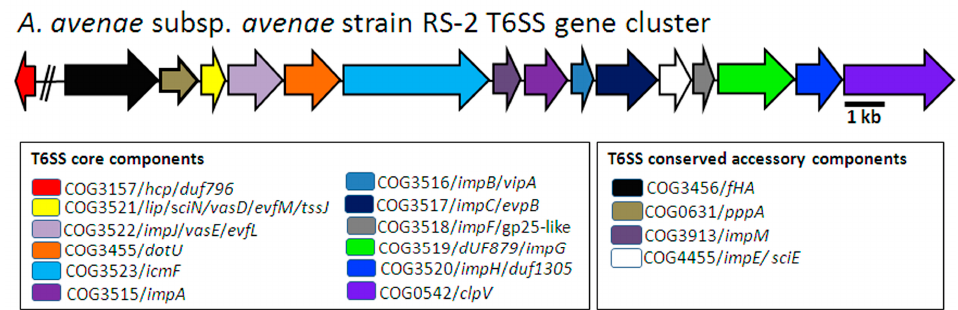
Figure 1. Schematic diagram of the genetic organization of Acidovoraxavenae subsp. avenae strain RS-2 T6SS gene cluster. Genes are indicated by arrows and the direction of the arrows represent the direction of transcription of the genes in genome. “//” indicates the presence of other genes but not belongs to T6SS. The database of Clusters of Orthologous Groups of proteins (COGs) was achieved from the National Center of Biotechnology Information (ftp://ftp.ncbi.nih.gov/pub/COG/COG2014/static/lists/listAciave.html).